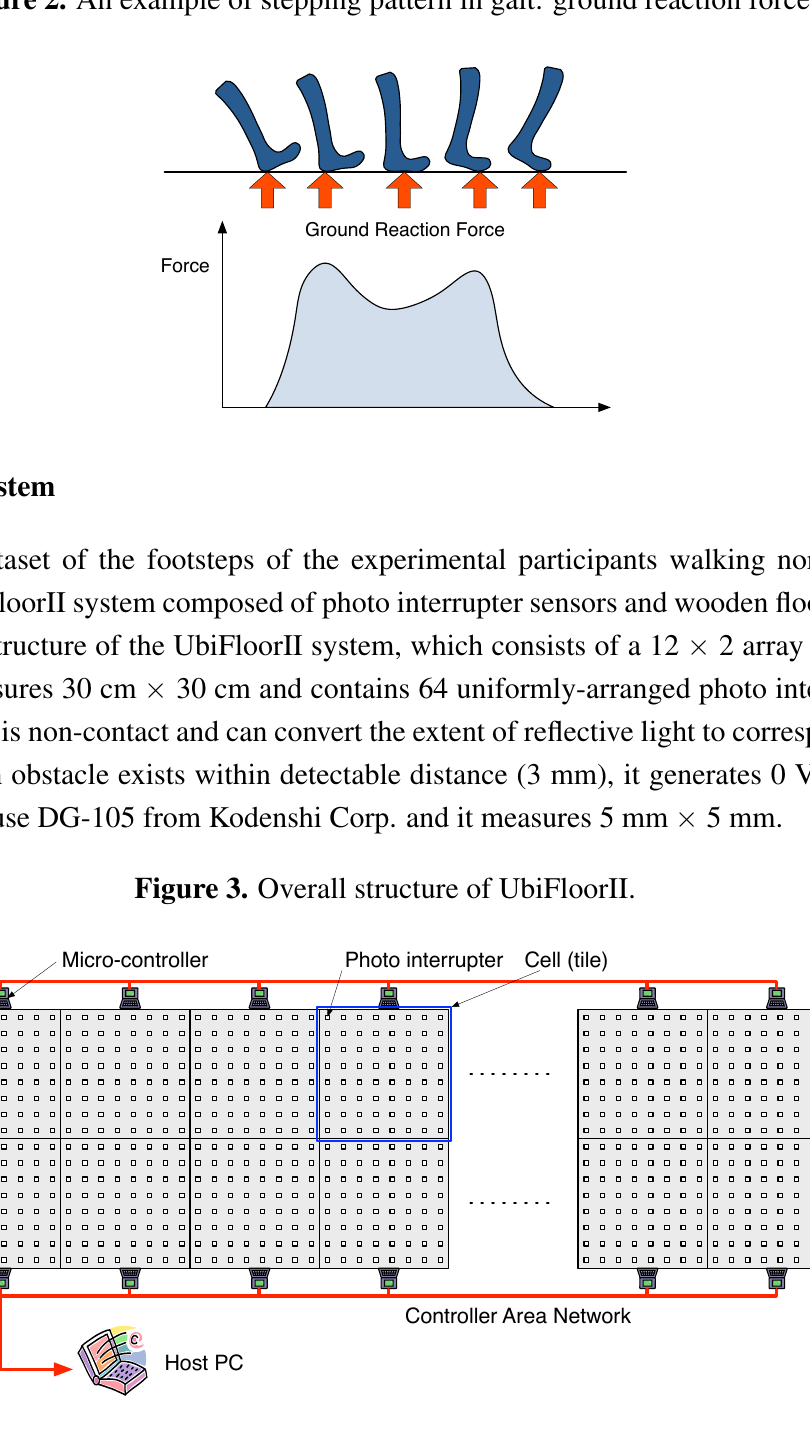
Figure 2. An example of stepping pattern in gait: ground reaction force.